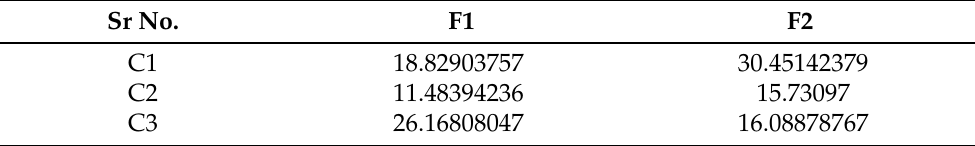
Table 16. The best centroids for Pathbased obtained by proposed approach. Sr No.